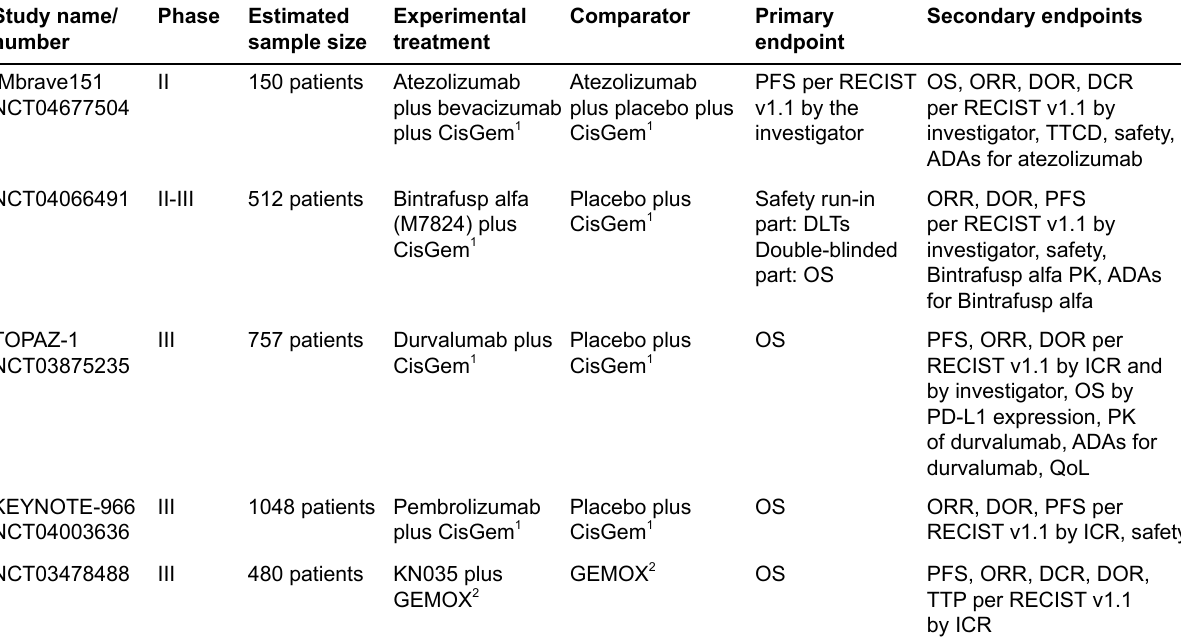
Table 3. Ongoing first-line randomized phase II-III trials with ICI for advanced